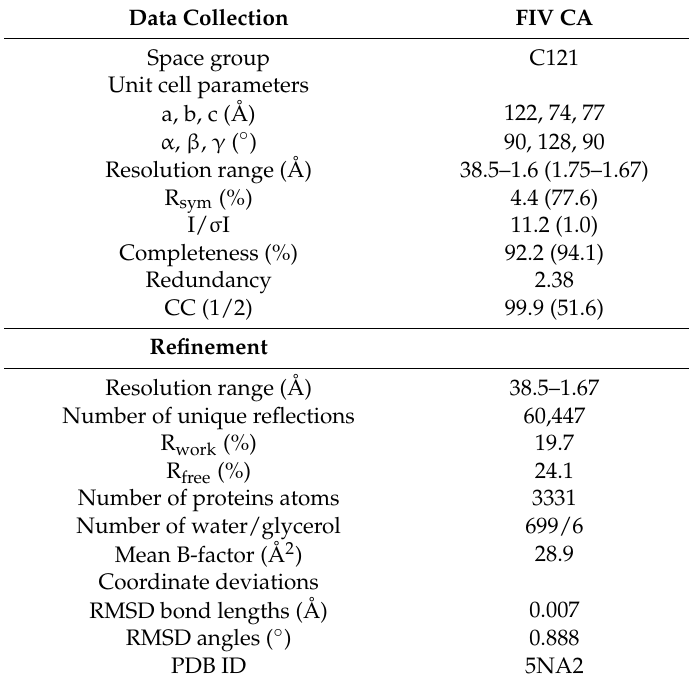
Table 1. Summary of X-ray data collection and refinement statistics. Values in parentheses are for the highest-resolution